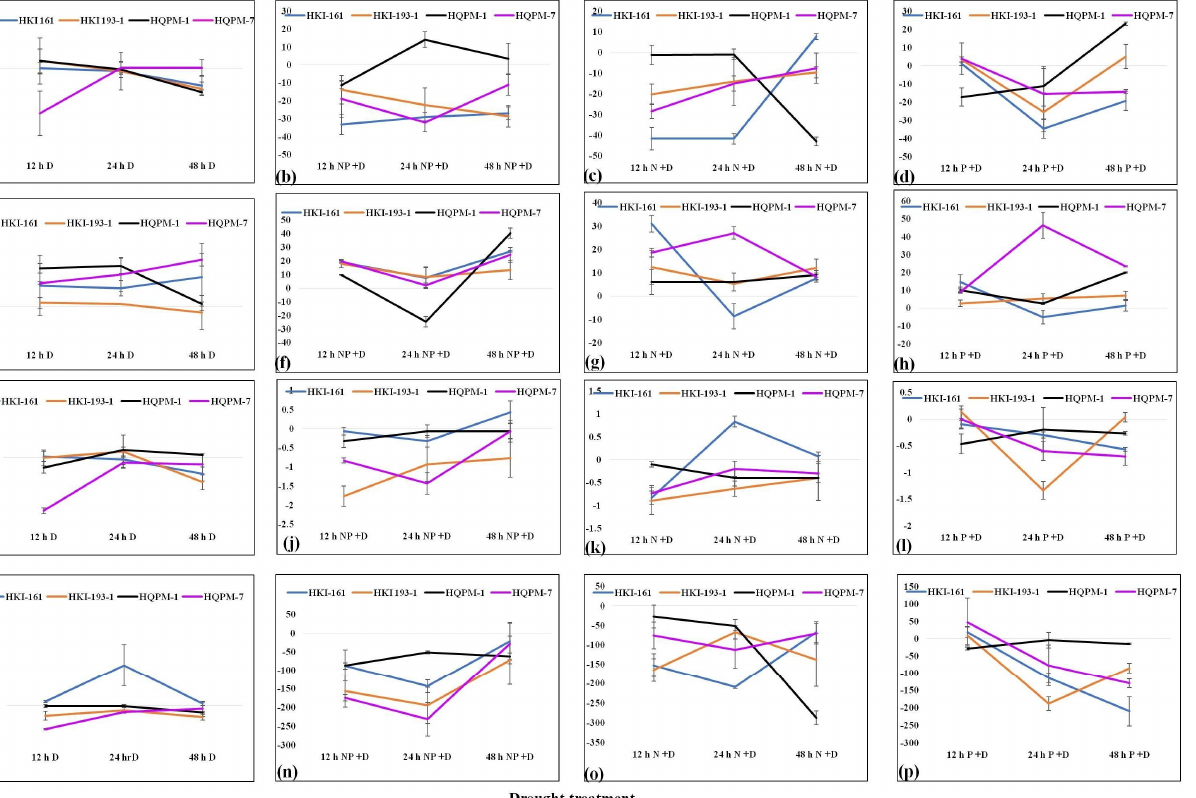
Figure 2. The graphs show average values of changes in shoot length ( a – d ), root length ( e – h ), stem width ( i – l ) and leaf area ( m – p ), for the maize seedlings growing under drought-stressed conditions (D) without and with pre-supplementation with nitrogen (N), phosphorous (P) and both NP. The watered plants with and without N, P and NP pre-supplements were used as controls in respective case and used as reference for calculating the changes in different growth parameters. Bars repre- sent the standard error of the mean among the three biological replicates.